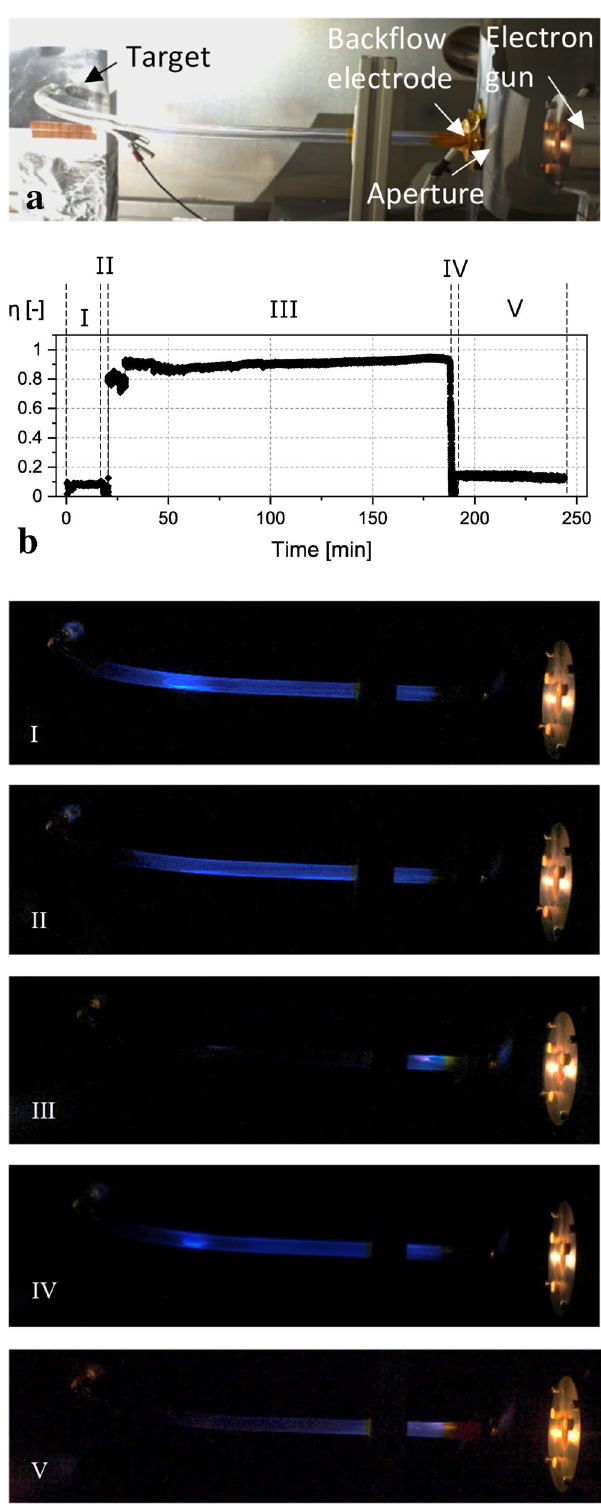
Figure 7. Photos of different glow states during the guiding test through a 90° capillary. ( a ) General Setup ( b ) Different guiding stages for the 90° Capillary, I: Poor transmission, II: 3 min before guiding started, III: During guiding process, IV: Guiding was interrupted, V: After guiding was